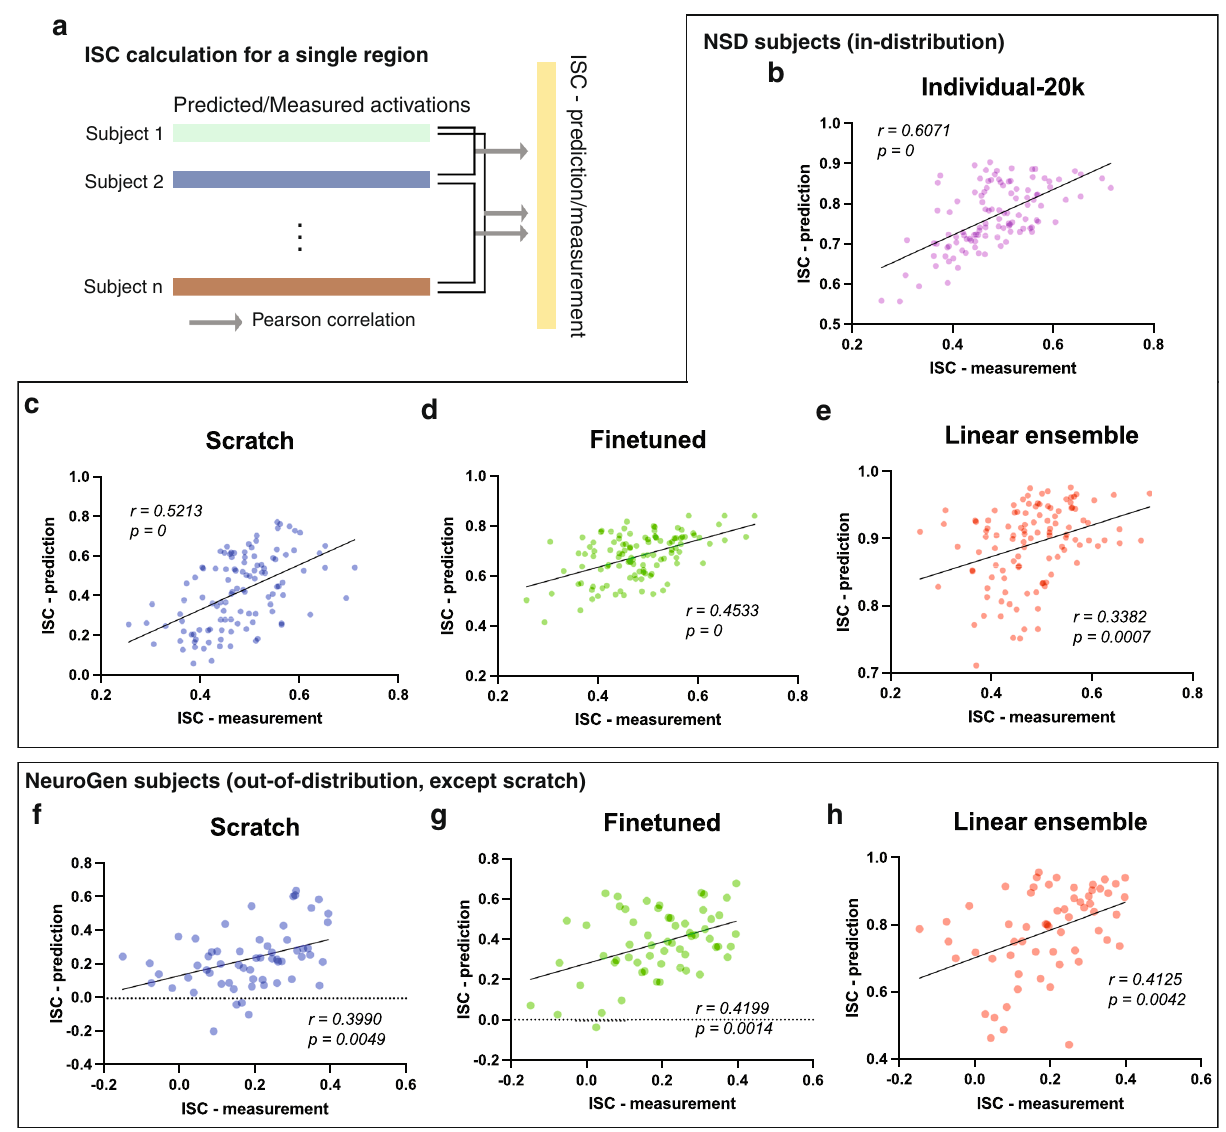
Fig. 4 Preservation of inter-individual differences within the encoding models. a Inter-subject correlations (ISC) are computed as the Pearson correlation between every pair of subjects ’ predicted (ISC-prediction) or measured (ISC-measurement) brain responses, calculated for each of four brain regions separately. The scatter plots show prediction consistency, which is the relationship between the ISC-measurement and ISC-prediction values across every pair of subjects for the images in the test set; the same region ’ s measured/predicted activity is used for both subjects. The number of points in each scatter plot are therefore the number of brain regions (4) * number of pairs of individuals (for NSD this is (7 × 8) / 2 = 23 and for NeuroGen this is (6 × 5) / 2 = 15). The scratch, fi netuned, and linear ensemble models here were created using a training dataset of 300 image-response pairs for NSD subjects. b – e represent the NSD subjects while f – h represent the NeuroGen subjects. Individual-20K models are not available for the NeuroGen individuals. The predicted responses have better SNR than the measured responses (due to the noise in the fMRI responses that is smoothed in the encoding models), thus note the x and y -axis ranges are quite different. All p values (calculated via permutation testing) are one-tailed and Bonferroni corrected for multiple